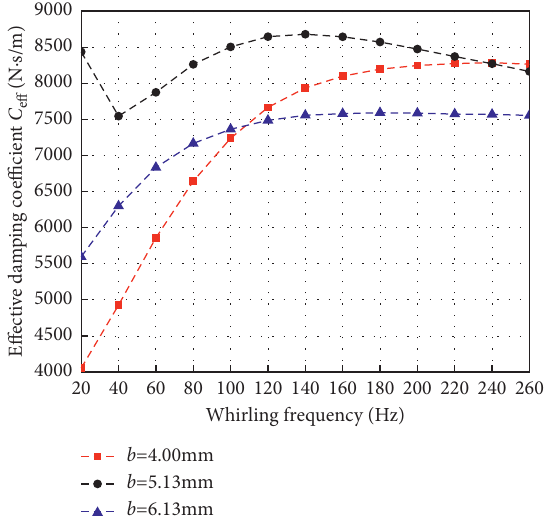
Figure 23: Effective damping coefficient vs. whirling frequency.